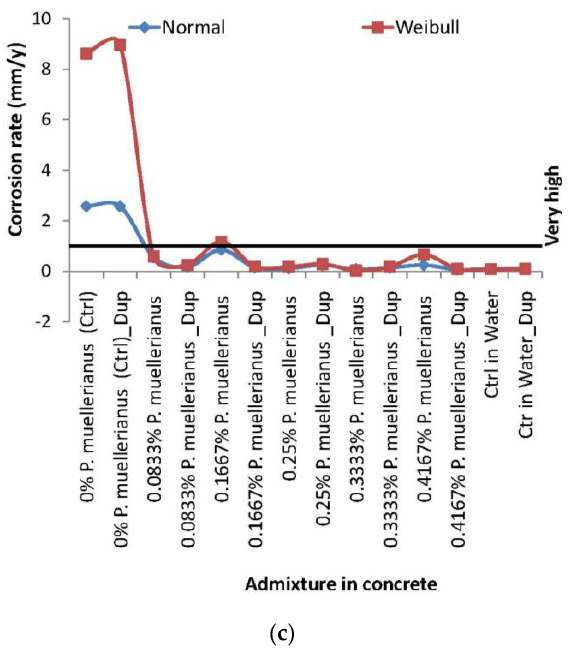
Figure 1. Statistical distribution analyses of corrosion test-variables: ( a ) mean ± standard deviation ranges of corrosion potential (CP) with linear plots of corrosion risks as per ASTM C876-91 R99 [45]; ( b ) mean ± standard deviation ranges of corrosion current (CC); and ( c ) mean corrosion rate (CR) with plot of classification of corrosion criteria as per [18,67].